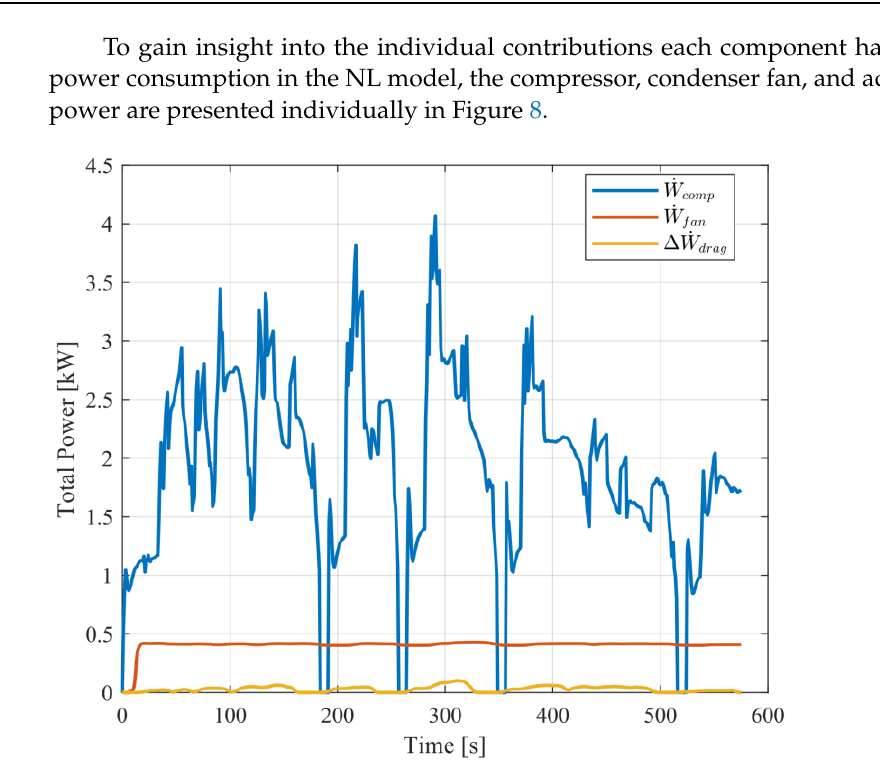
Figure 8. Compressor, condenser fan, and drag power consumption of NL model for SC03 cycle.